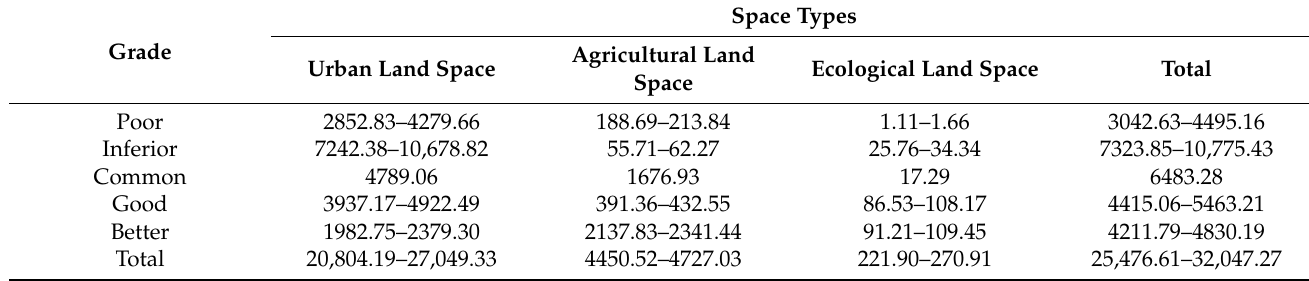
Table 8. Results of population carrying capacity estimation (thousand